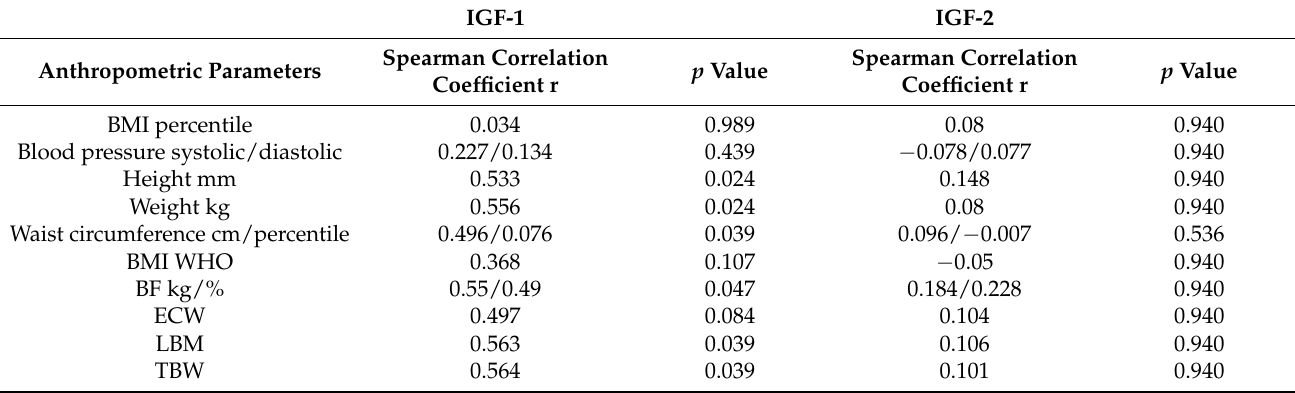
Table 3. Correlations of anthropometric parameters with IGF-1 and IGF-2 concentrations.